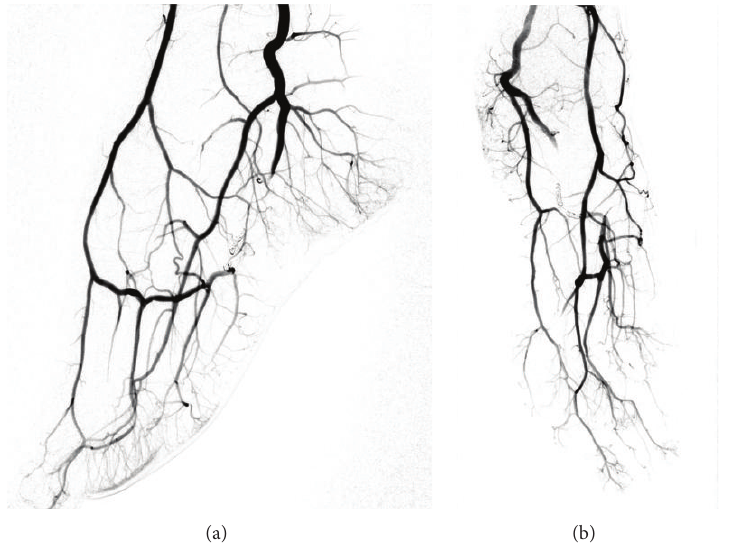
Figure 4: Final angiography confirming a complete occlusion of the